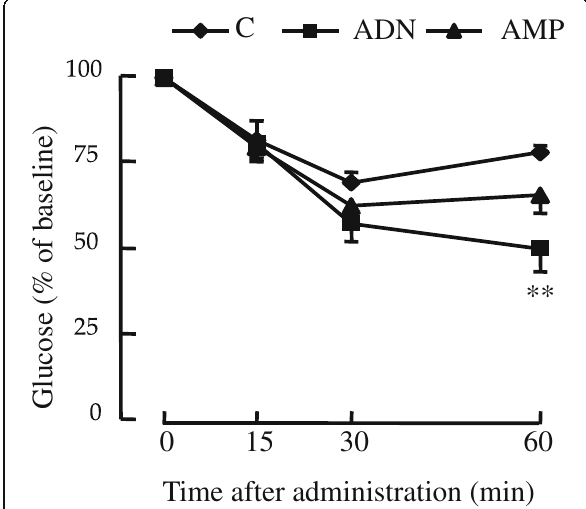
Fig. 4 Changes in blood glucose during insulin tolerance tests of mice with high-fat diet-induced obesity administered ADN or AMP. Values are means ± SEM, n = 5 or 6. ** p < 0.01 versus the control group. C, control group; ADN, adenosine group; AMP, adenosine-5 ′ -monophosphate